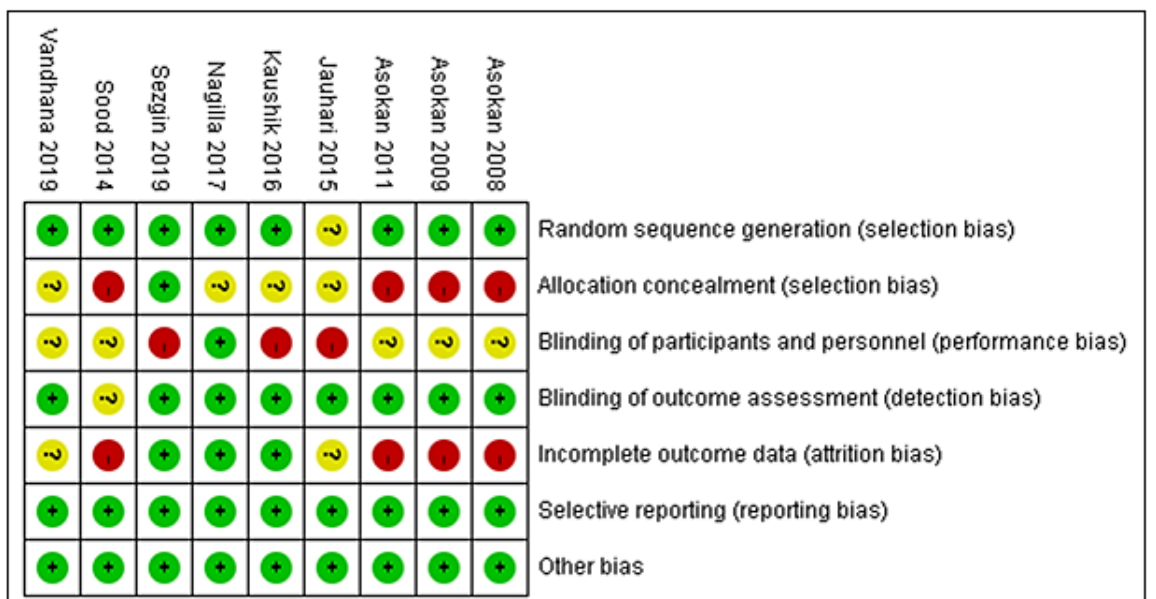
Figure 2. The risk-of-bias assessment results of the nine included trials.